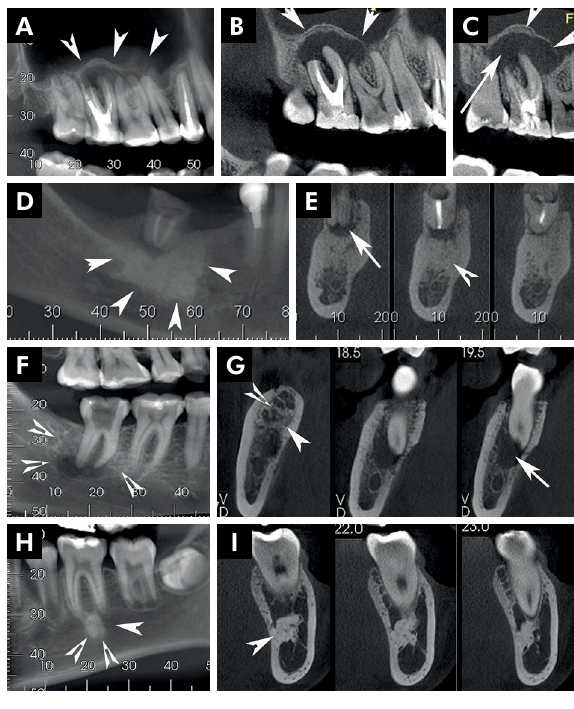
Figure 1. Reactional osteogenesis: Cone beam computed tomography (CBCT) images showing a hyperdense irregularly shaped structure (arrow head) in the right maxillary sinus (A-B), associated with an inflammatory hypodense periapical lesion (arrow) (C). Condensing osteitis (CO): CBCT presenting a diffuse hyperdense lesion in the apex of a mandibular molar (arrowhead) (D), adjacent to an inflammatory periapical lesion (arrow) (E). Chronic osteomyelitis: CBCT views show a mixed hypodense/hyperdense lesion (F) with evident sclerotic changes (arrow head) in the periapical region of a mandibular right molar, and with the presence of an inflammatory hypodense periapical lesion (arrow) (G). Idiopathic osteosclerosis (IO): In CBCT images, it is observed as a hyperdense round lesion (arrowhead) located under the apex of an apparently non-infected tooth (H). IO lesion is clearly separated from the root of the adjacent tooth by a visible periodontal membrane